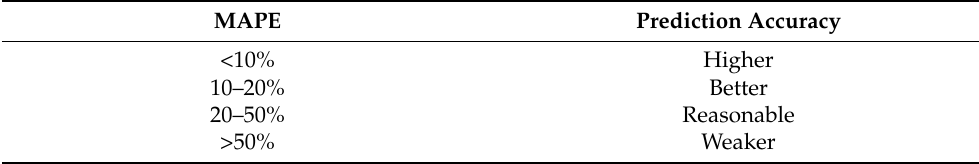
Table 3. Test criteria for the forecasting